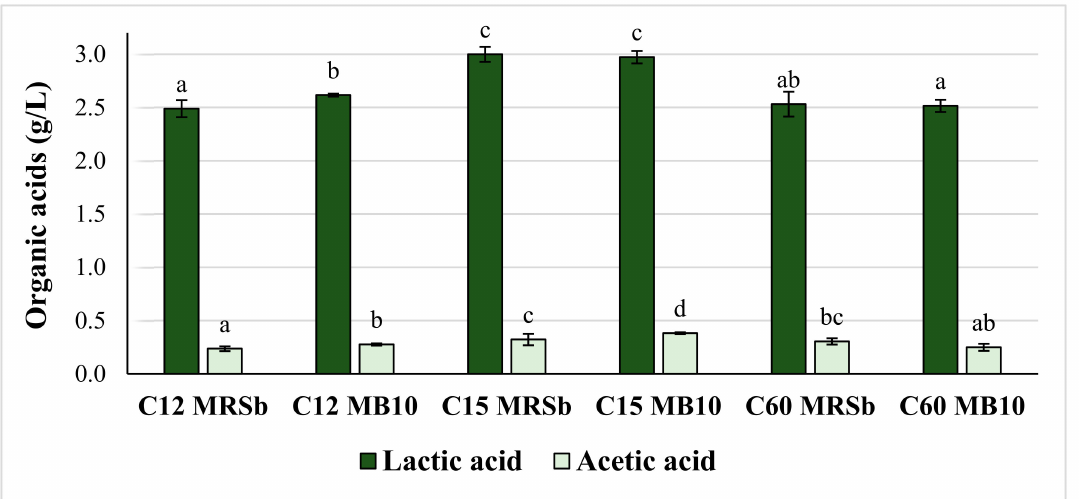
Figure 2. The concentration of organic acids produced by LAB in meat broth (MB10) and MRS broth (MRSb) after incubation for 48 h at 37 ◦ C. The meat broth was prepared with 10% freeze-dried loin pork and fermented by P. pentosaceus C12, P. pentosaceus C15, and L. plantarum C60. Different letters represent statistical differences in the same group of molecules between treatments ( p ≤